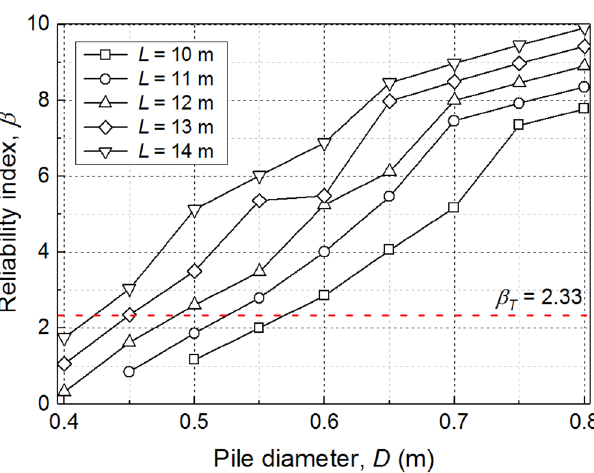
Figure 6. Reliability index estimated using first-order reliability method in different design